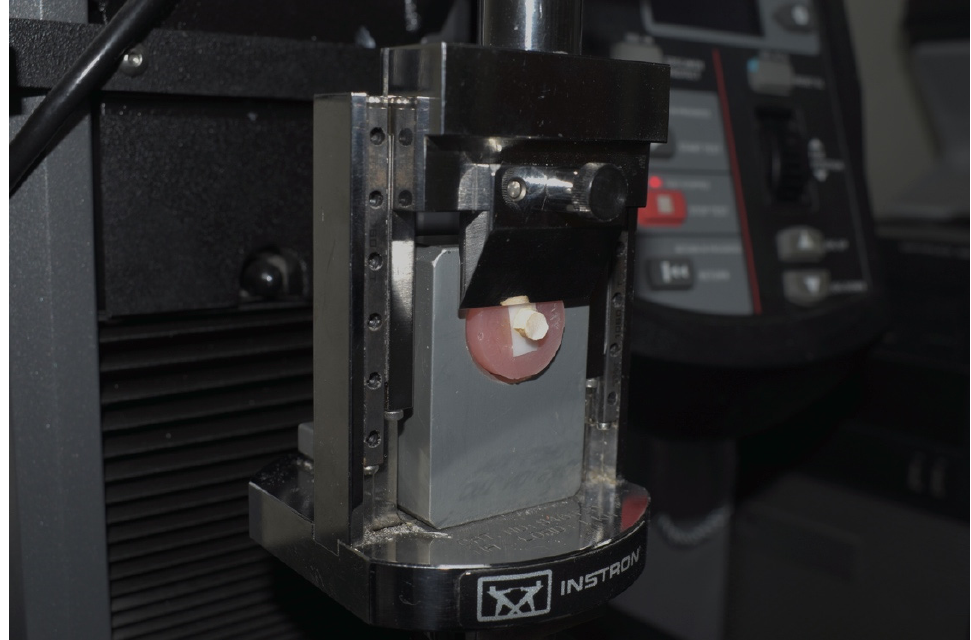
Figure 3. Specimen mounted in universal testing machine for shear bond strength test.